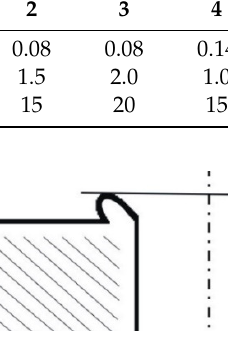
Figure 7. Burr height h —value measured during the experiment.